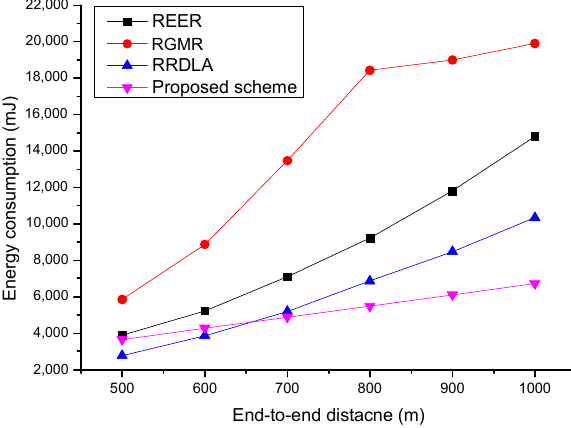
Figure 9. Average energy consumption vs. end-to-end distance with for 80% of the link